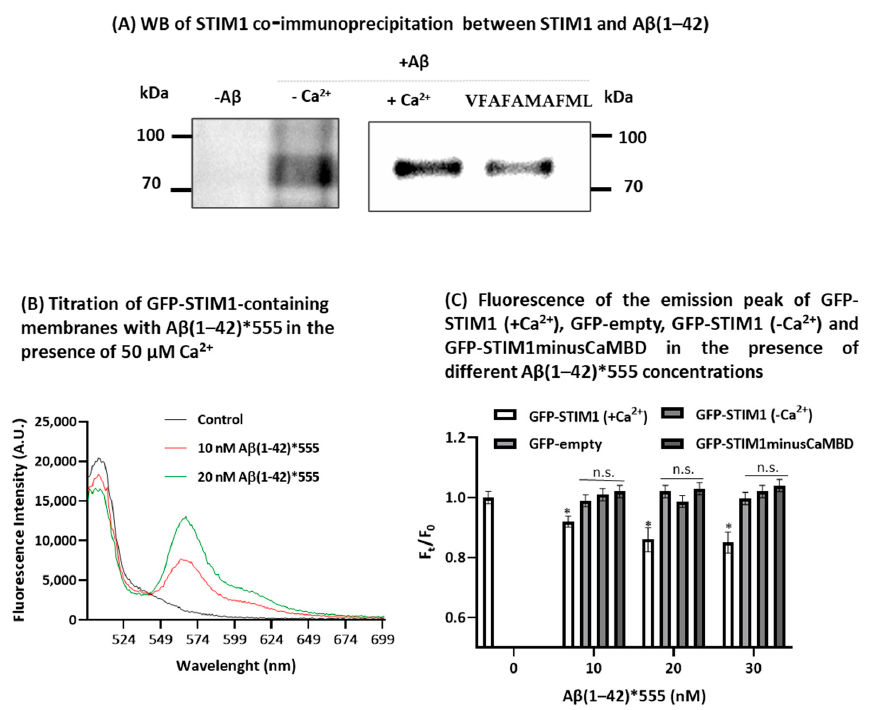
Figure 4. STIM1 is a target for A β (1-42). Panel ( A ): Western blots (WB) of STIM1 (anti-STIM1) after co-immunoprecipitation assay with mouse anti-A β antibody in the absence and presence of Ca 2+ , and in the presence of Ca 2+ plus 1 µ M of the peptide antagonist VFAFAMAFML, as described in the Materials and Methods section. Panel ( B ): titration of the fluorescence of STIM1-GFP in Ca 2+ medium [STIM1-GFP (+Ca 2+ )] with different concentrations of A β (1-42)*555, using 10 µ g/mL of HEK293 cell lysate containing STIM1-GFP in the absence (black trace) and after the addition of 10 nM (red trace) and 20 nM (green trace) of A β (1-42)*555. Fluorescence spectra were recorded at room temperature in buffer 50 mM N-[2-hydroxyethyl] piperazine-N (cid:48) -[2-ethanesulfonic acid] (HEPES), 100 mM KCl, 2 mM MgCl 2 , and 50 µ M CaCl 2 (pH 7.05). The spectra were acquired between 20 and 30 min after the addition of the indicated A β (1-42)*555 concentration, with an excitation wavelength of 488 nm, and excitation and emission slits of 2 nm. Panel ( C ): fluorescence of the emission peak of STIM1-GFP(+Ca 2+ ), GFP-empty, STIM1-GFP(-Ca 2+ ), and STIM1-GFPminusCaMBD, in the presence of different A β (1-42)*555 concentrations. F and F 0 are the fluorescence in the presence and the absence of A β (1-42)*555, respectively. The results shown are the means of triplicate experiments ± SEM (*) p < 0.05; n.s.—not statistically